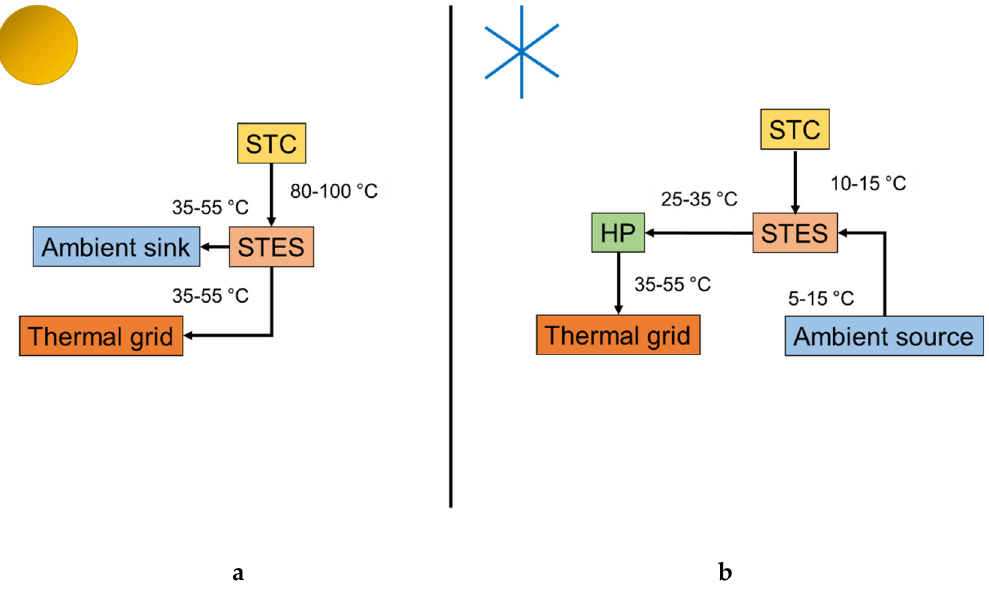
Figure 15. TCM seasonal storage charging phase ( a ) and discharging phase ( b ).